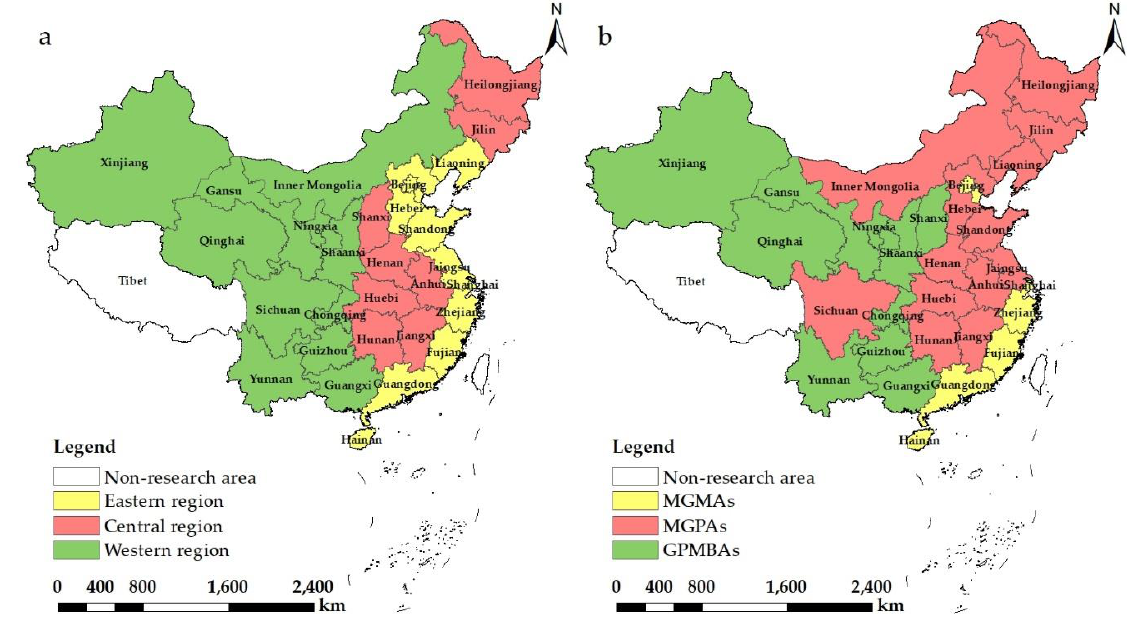
Figure 3. The research area and regional classification. ( a ) three regions in accordance with their locations in eastern, central and western China. ( b ) three food function